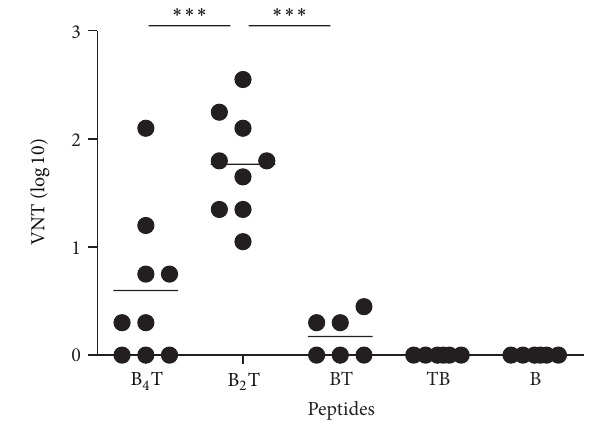
Figure 2: Antibody responses to FMDV in sera analyzed by neutralization assay at day 39 postimmunization. The VNT titers determined in each group of mice were expressed as the reciprocal (log 10 ) of the last dilution able to neutralize 100 TICD 50 of homolo- gous virus. Animals with VNT ≥ 1 are considered seropositive. Each symbol represents the value for an individual animal. Horizontal lines indicate the mean value for each group of animals. Statistical differences between B 2 T group and the others are indicated by 𝑃